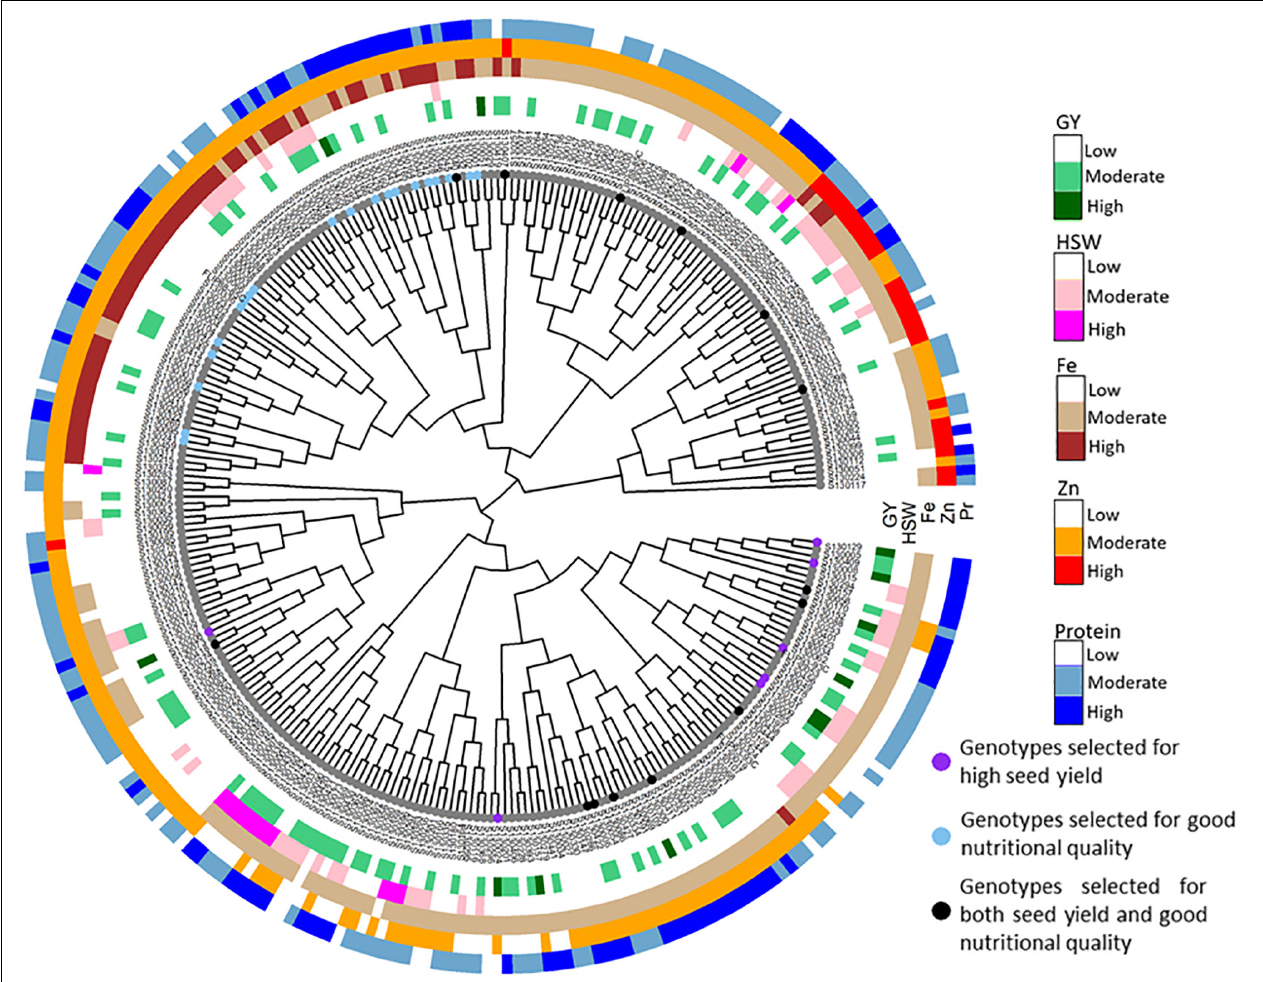
FIGURE 8 | Dendrogram showing the total list of tested genotypes grouped in different clusters generated based on agronomic performances (GY and HSW) and nutritional quality traits (protein, Fe, and Zn contents).